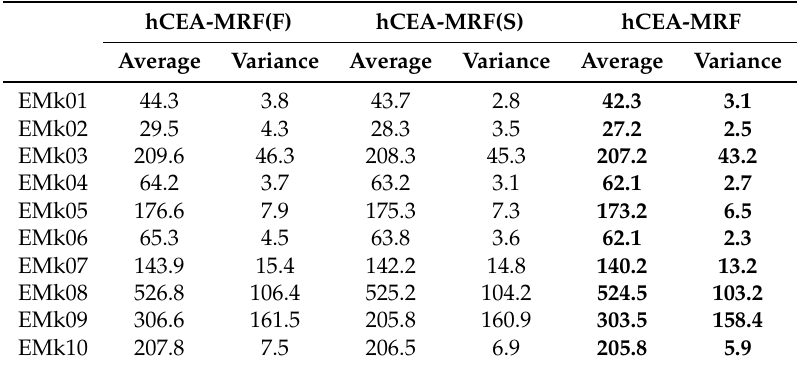
Table 12. The performance of different decomposition strategies for the generated instances by exponential